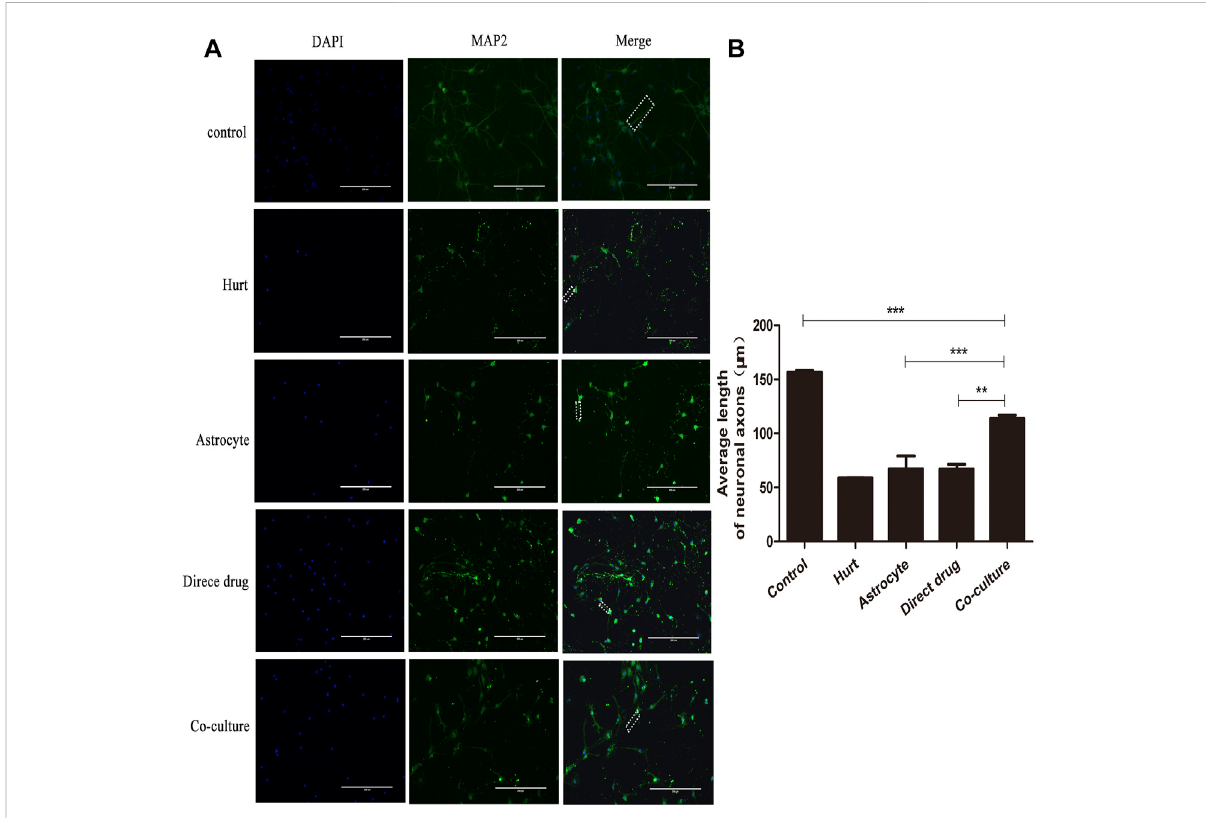
FIGURE 10 TFHL conduces axonal regeneration of injured SMNs. (A) Under ×20 magni fi cation, the regeneration of spinal motor neuron axons in each group was observed by MAP2 Immuno fl uorescence, scale bars = 200 μ M. DAPI is nuclear staining with blue fl uorescence; MAP2 is neuron tubulin with green fl uorescence; Merge is a composite image of the former two. (B) The comparison of the average length of axon regeneration of SMNs in eachgroup.Thewhitewireframeshowsaxons.Alldataareexpressedasthemean±SD.Differencesamonggroupsweredeterminedwithone- way ANOVA followed by a least-signi fi cant difference post hoc test. * p < 0.05, ** p < 0.01, *** p < 0.001. SMNs: spinal motor